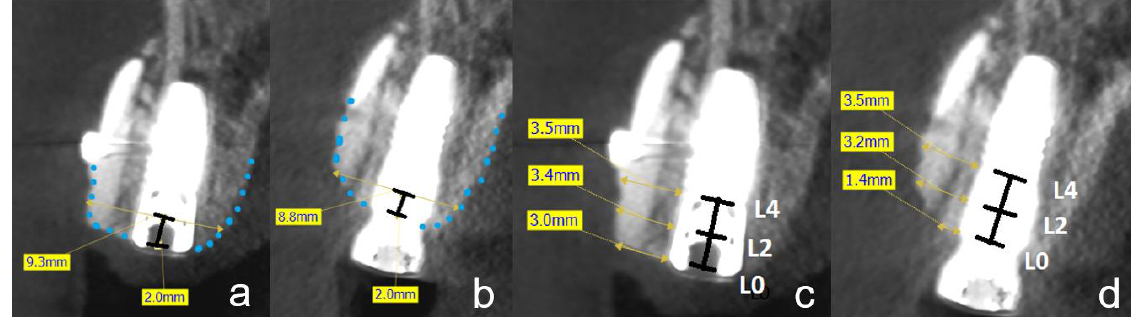
Figure 4. CBCTs after lateral ridge augmentation with simultaneous implantation and after implant exposure. ( a ) A CBCT in the sagittal plane shows an implant region 12 with TST at the time of lateral ridge augmentation. The buccal tooth shell is clearly visible. Dotted lines trace the outline of the alveolar ridge. The measurement of the bucco-oral alveolar ridge width was performed at level L2. In this case, the ridge width was 9.3 mm. ( b ) The same procedure of the measurement of the bucco-oral alveolar ridge width was performed at the time of implant exposure. The tooth shell shows some resorption only at L0. ( c ) Measurements of the thickness of the buccal bone lamella at three different levels (L0, L2, and L4) at the time of lateral ridge augmentation. ( d ) Measurements of the thickness of the buccal bone lamella at three different levels (L0, L2, and L4) at the time of implant exposure.